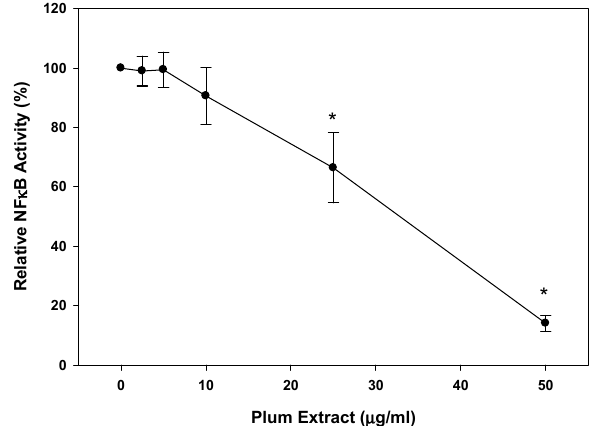
Figure 6. Effects of plum extract on NFkB activation. The effect of plum extract on TNF α -mediated NFkB activation was measured in the A549/NF κ B-luc reporter stable cell line. Activity was measured in terms of luciferase activity. The data are reported as the relative percent inhibition of TNF α -mediated NFkB activation. The data are expressed as mean ± SD for at least three experiments. All comparisons were made to control (untreated cells) using one-way ANOVA; significant di ff erences are reported at * p < 0.05.